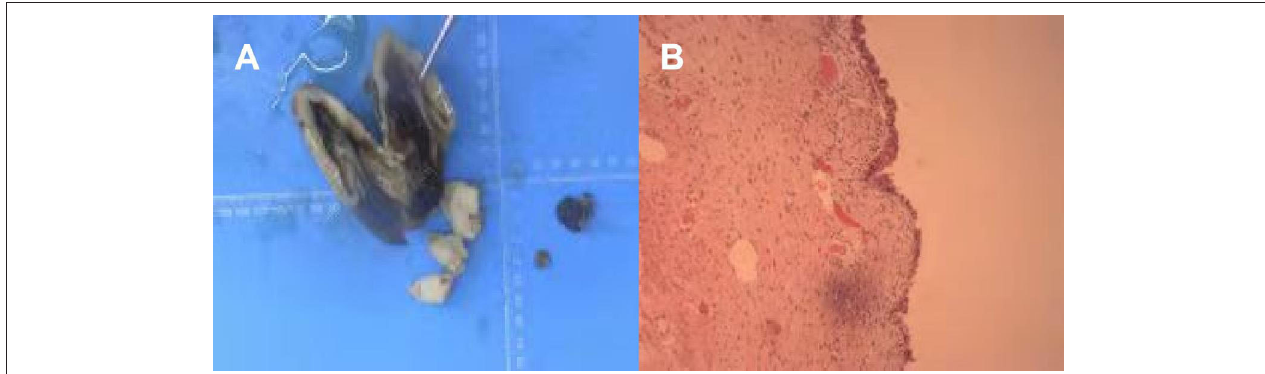
FIGURE 5 | The ultrasound images 2 months after the operation. (A–D) No abnormalities in uterus and double appendages.